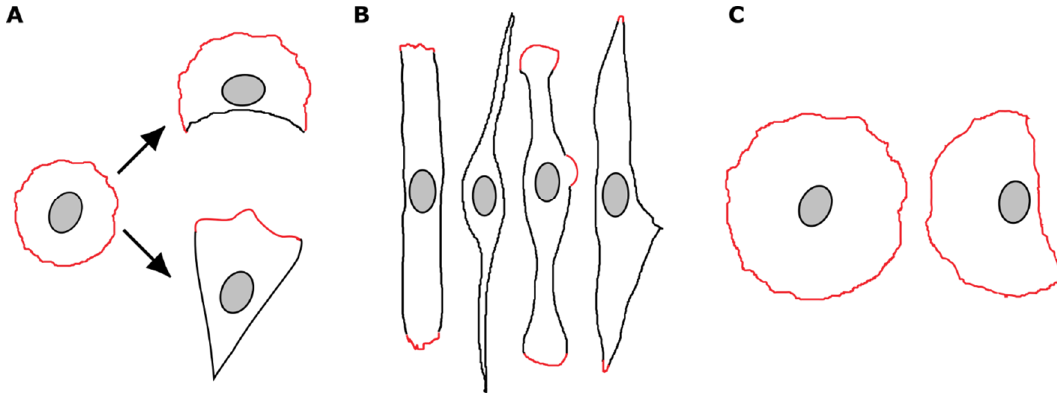
Figure 7. Schematic representation of the shape of Rat2 fibroblasts. ( A ) In radially spreading Rat2 cells, the formation of one non-protruding region results in a crescent-like cell shape while two stable concave non-protruding areas define the extended cell rear. ( B ) FAK-depleted cells adopt an elongated shape with protruding regions at cell poles. Protrusions also often develop at cell sides in the nuclear region. ( C ) Rack1-depleted cells adopt a round phenotype with a centrally located nucleus. A minor fraction of cells adopts a half-round shape with the nucleus displaced to the cell periphery. The protruding regions are highlighted in red, non-protruding cell edges are in